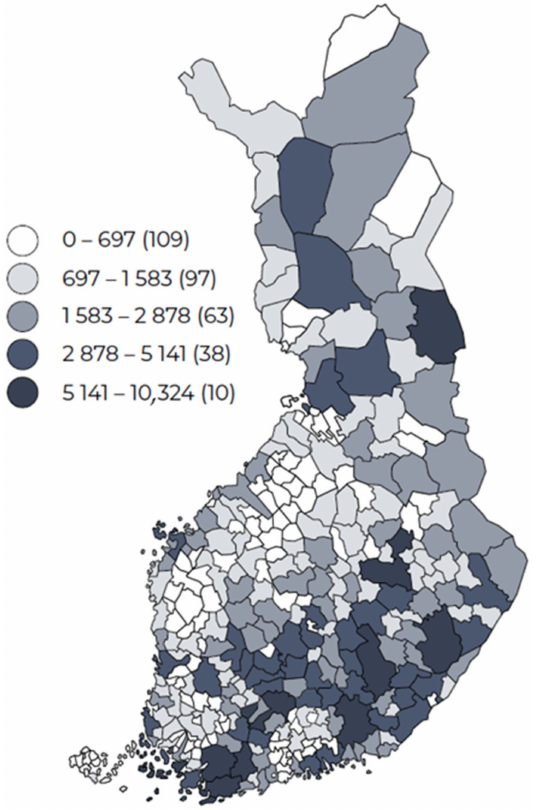
Figure 4. Distribution of cottages by municipalities in